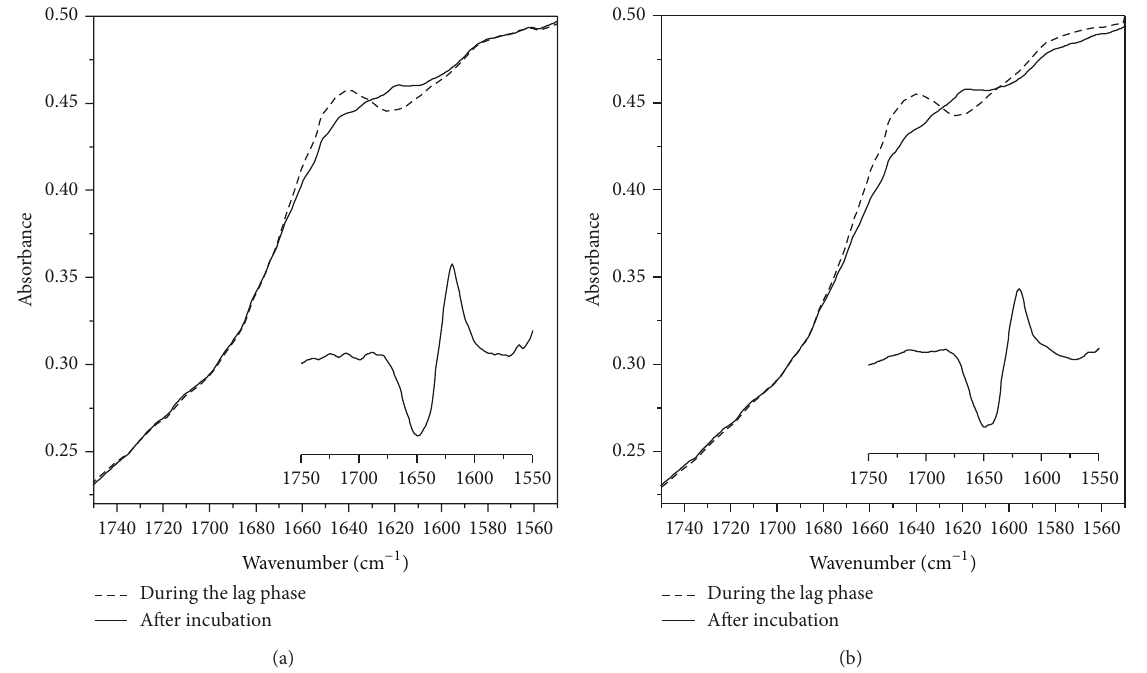
Figure 4: FTIR results for the inhibitory effect of rifampicin on HEWL fibrillation (a) without rifampicin in the incubation solution and (b) with rifampicin in the incubation solution. Dash line: raw spectrum taken during the lag phase; solid line: raw spectrum taken at the end of incubation. Inset: difference